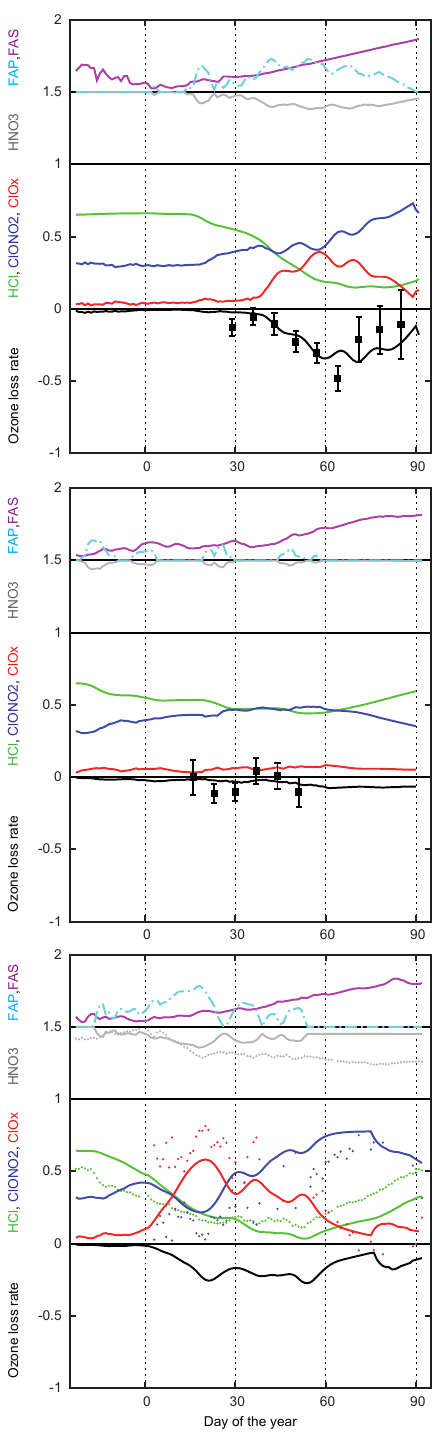
Figure 4. Same as Fig. 2 for the Arctic winters 1996/1997 (top), 1997/1998 (middle) and 2007/2008 (bottom). Match data are only available for 1996/1997 and 1997/1998 and satellite data only for 2007/2008.